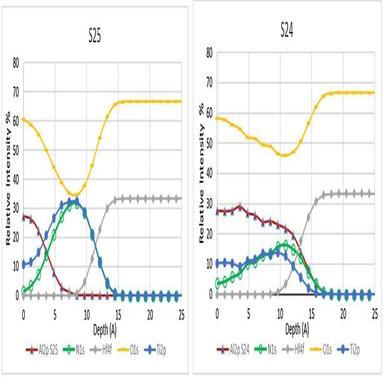
S25 and S24 ARXPS profile.